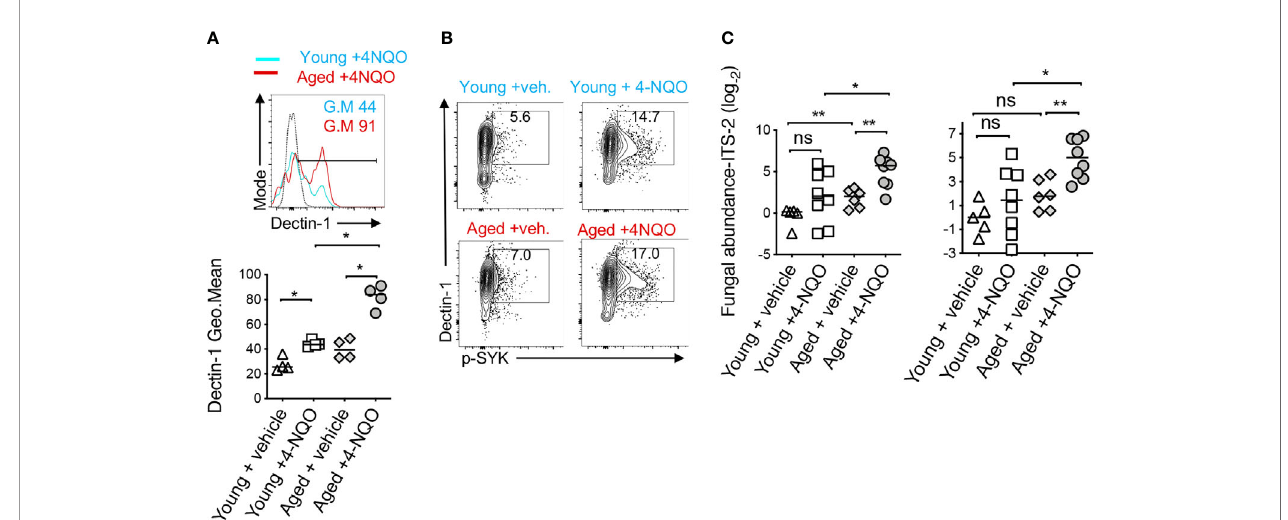
FIGURE 6 | Aged mice show elevated dectin-1 signaling in immune cells in the tongue and increased fungal abundance in saliva. Tongue samples were processed for fl ow cytometry. Contour plots (top) and statistics (bottom) showing dectin-1 expressing CD45 + cells (A) . Contour plots showing % of Dectin-1 + and phosphorylated SYK (p-SYK) expressing CD45 + cells (B) . Saliva swabs collected at 12, 15, and 23 weeks were pooled. qPCR was performed to quantify fungal DNA using ITS-2 and fungi-quant PCR primers (C) (28, 29). Relative abundance was standardized to input DNA using b -actin as reference. (Mann-Whitney test *P < 0.05, **P <